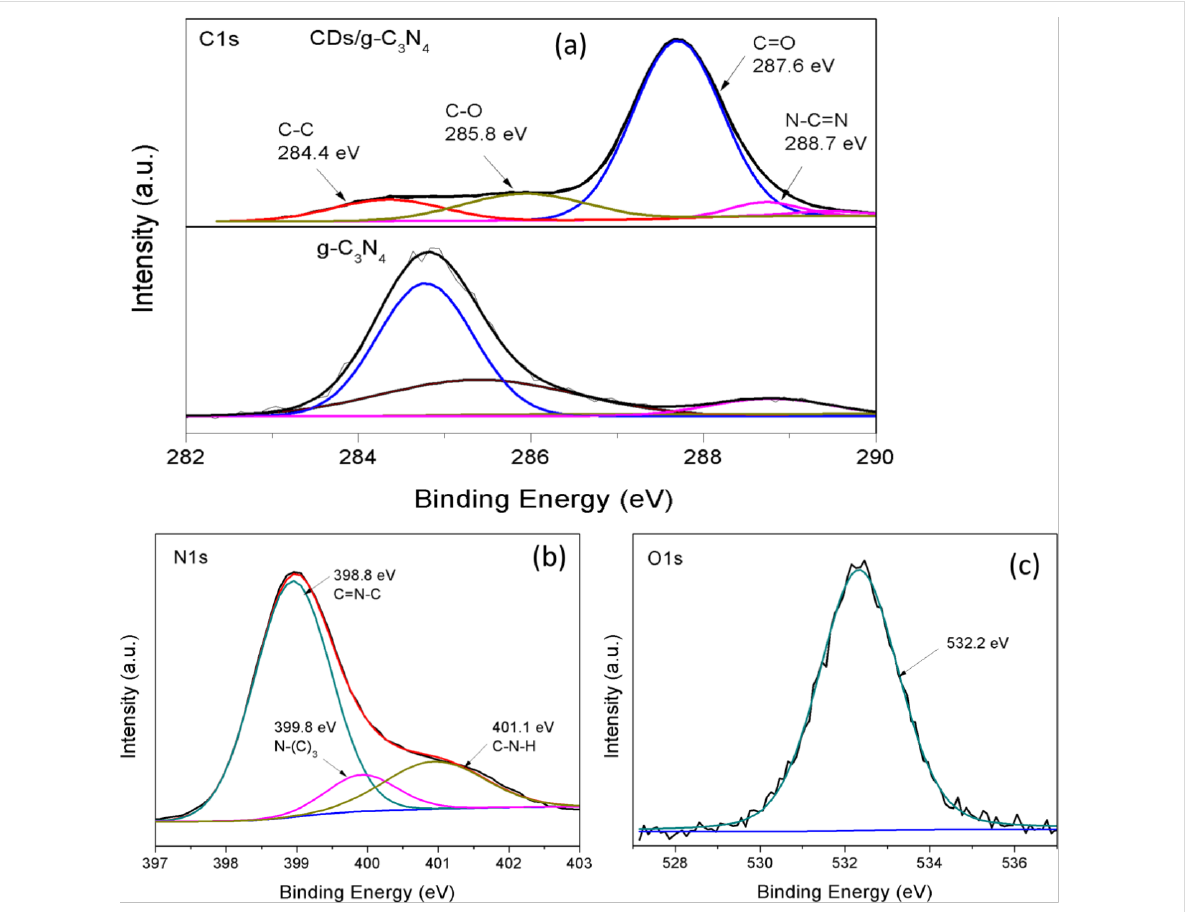
Figure 4: X-rat photoelectron spectroscopy (XPS) of (a) C 1s (b) N 1s, (c) O 1s for CD/g-C 3 N 4 (0.5), and (d) C 1s for g-C 3 N 4